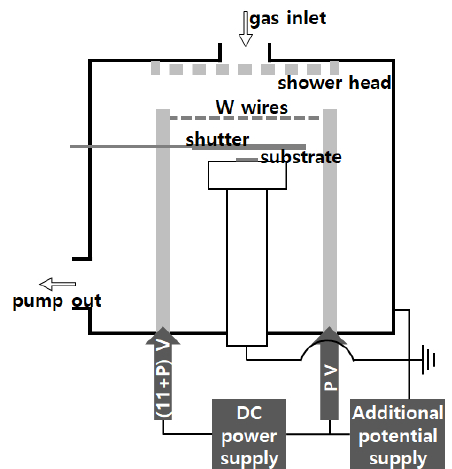
Figure 1. Schematic of the hot-wire chemical vapor deposition (HWCVD) system showing the electric connections of the hot-wire DC power supply and the additional potential supply to apply bias to the wires.